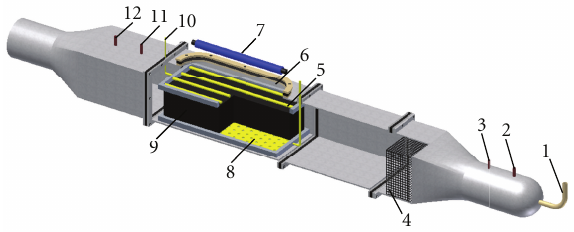
Figure 5: Experimental section. (1) Reactant stream inlet. (2) Zero air inlet (3) Humidified air inlet. (4) Mixer. (5) Electrode wire (6) Quartz glass window. (7) UV lamp (8) Electrode plate. (9) TiO2 film. (10) Lead thread. (11) Sampling port. (12) Humidity and temperature sampling port.